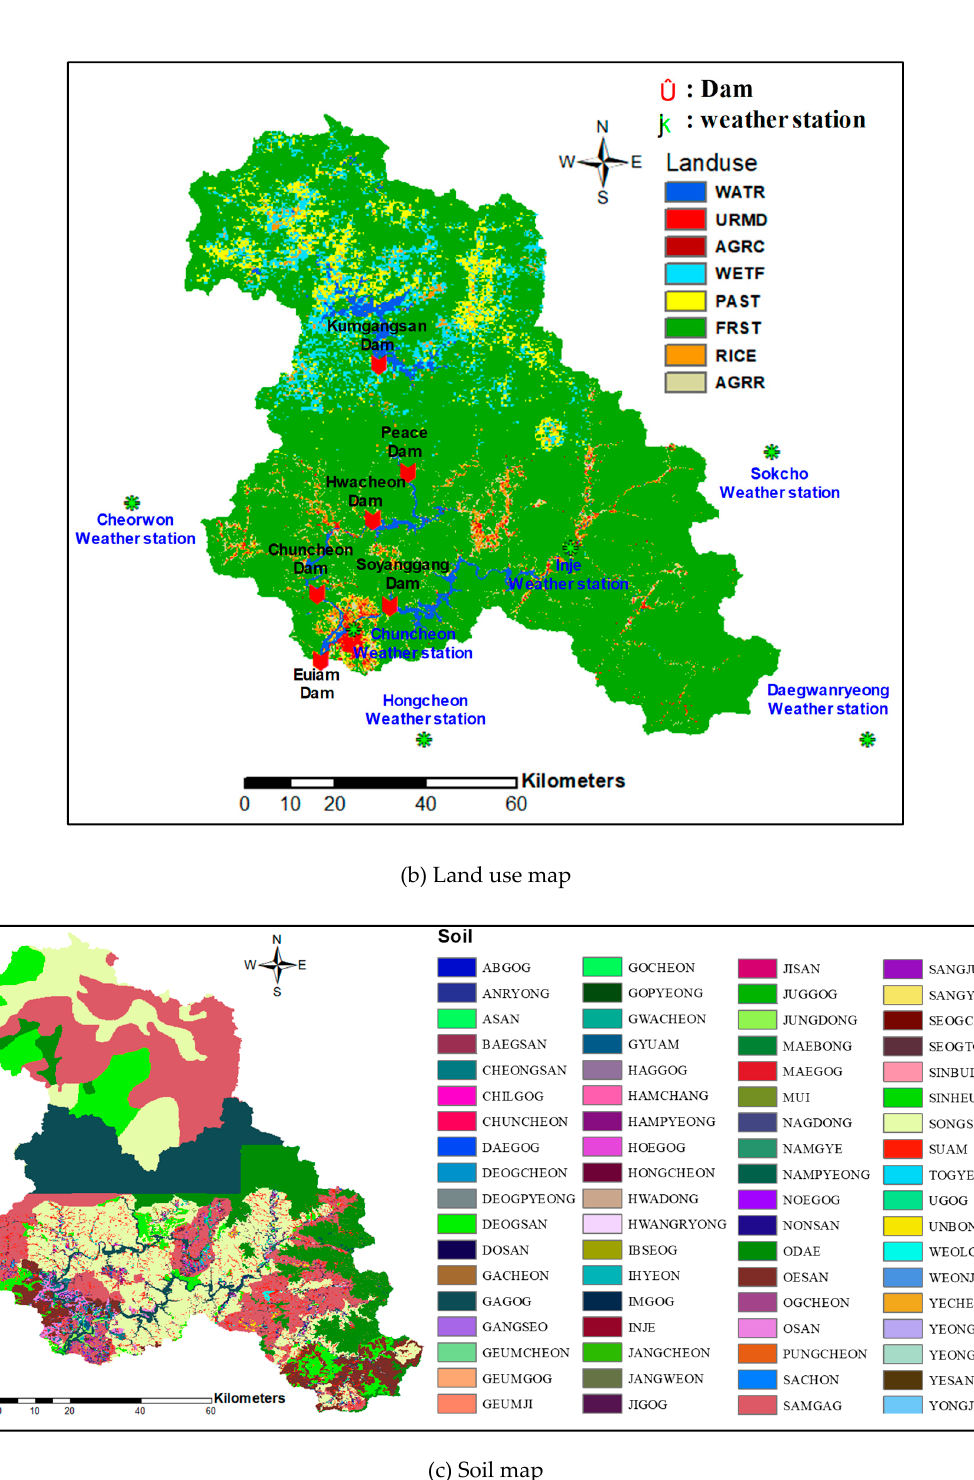
Figure 6. Input data of Soil and Water Assessment Tool (SWAT) for the Euiam Dam watershed (( a ) DEM, ( b ) Land Use Map, ( c ) Soil Map).